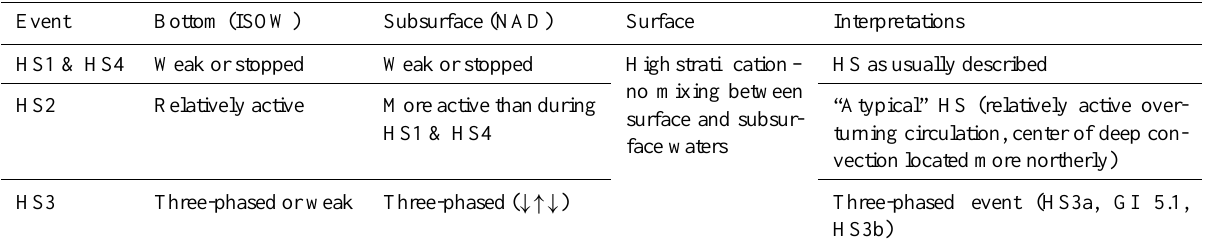
Table 1. Synthesis of the main hydrologic features depicted at the study site during Heinrich stadials (HS) 1 to 4. Event Bottom